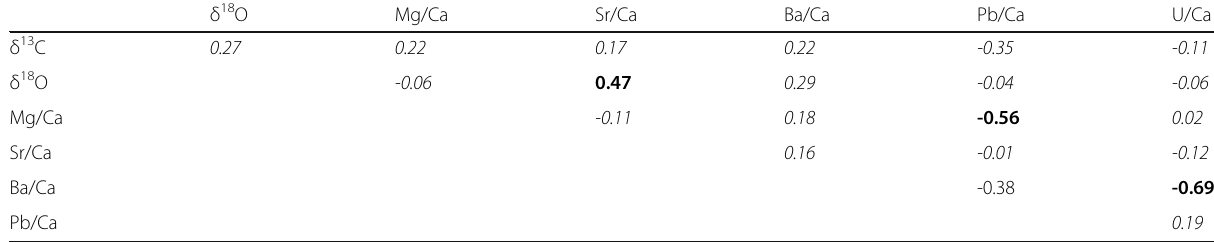
Table 2 Correlations between average values of sclerosponge geochemistry